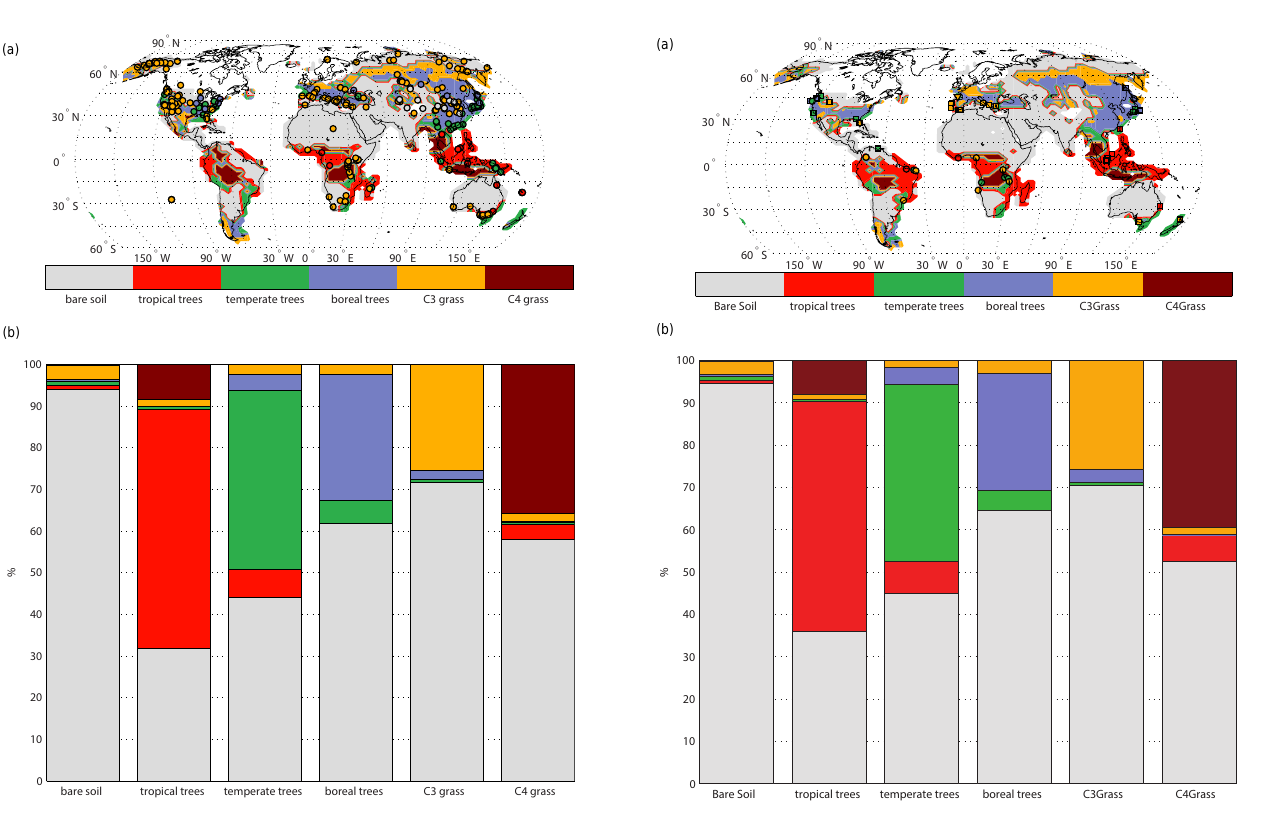
Figure 6. (a) Model–data comparison of mega-biome distribution for HS_exp based on dominant PFT type simulated by ORCHIDEE. For each grid cell, the fraction of bare soil, tropical forests, tem- perate forests, boreal forests, and C3 and C4 grasses is considered. The type covering the greatest cell fraction is the dominant type. Note that dominant bare soil fraction denotes more than 80%. Cir- cles denote HS_exp mega-biomes inferred from pollen and plant macrofossil records compilation. Refer to Table 4 to see how PFTs simulated by ORCHIDEE and reconstructed vegetation have been assigned to the mega-biomes mapped in this figure. (b) Detail of the averaged vegetation composition in grid cells occupied by a domi- nant mega-biome for